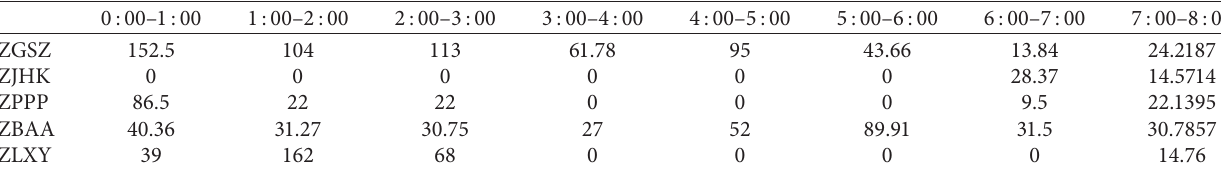
Table 3: Samples of average flight delay (minute).